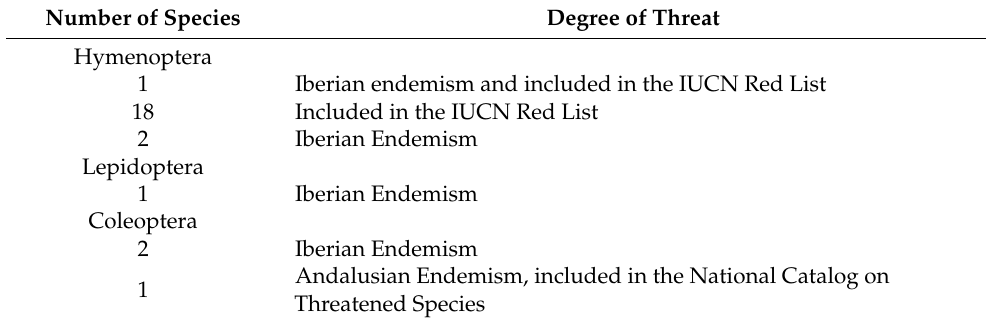
Table 5. Threatened arthropod species found in the study. IUCN: International Union for Conservation